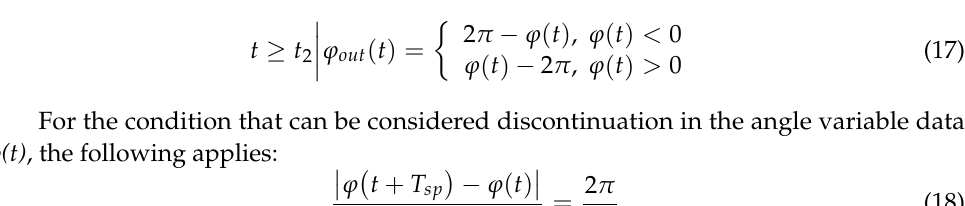
Figure 8. A vector difference Δ between the calculated position of the position vector of the p 7 ef- fector and the position of the A s points.